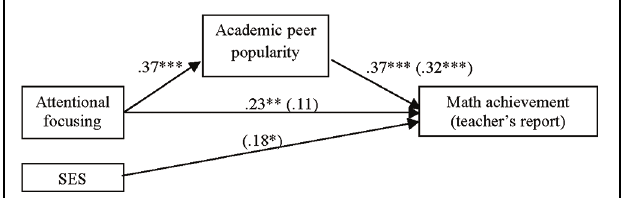
FIGURE 1 | Relational model with academic academic peer popularity as mediator in the attentional focusing (AF) and math achievement (standard test) association. Numbers in the figure are beta coefficients ( ˆ β for mediational model are in parentheses). ∗ p < 0.05; ∗∗ p < 0.01; ∗∗∗ p < 0.001.